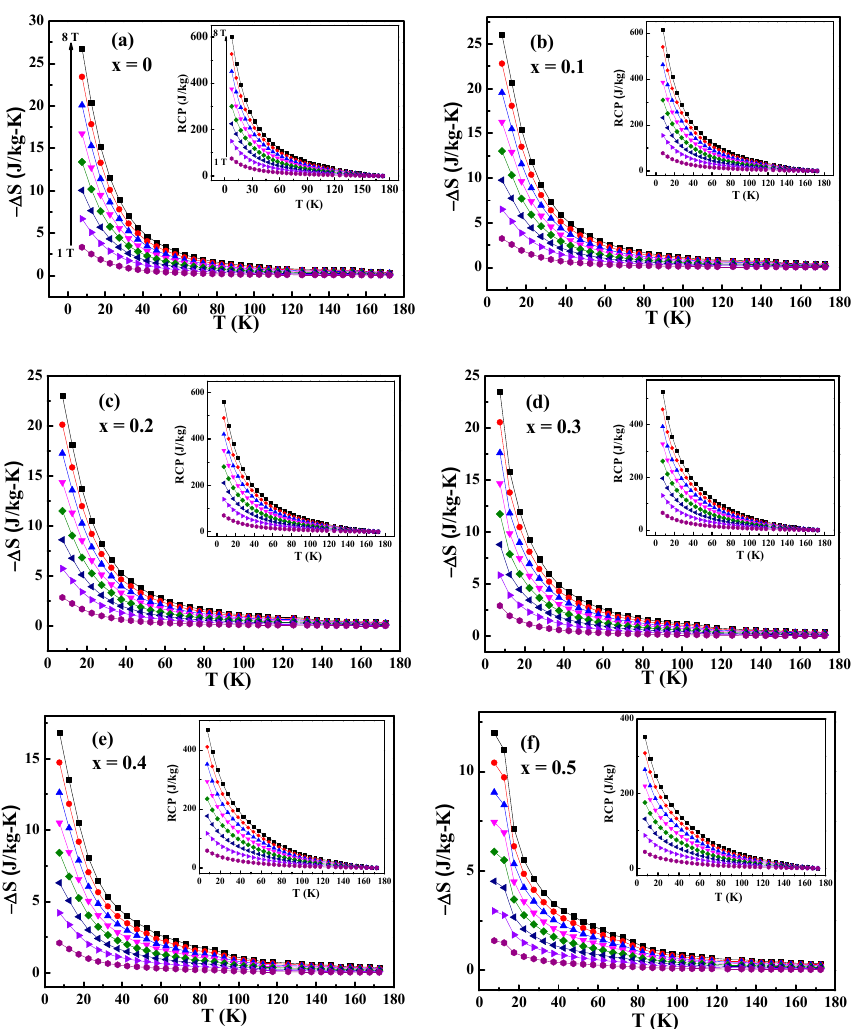
Figure 9. ( a – f ): The temperature dependence of magnetic entropy change ( − ∆ S ) and relative cooling power (inset) of GECMO series in magnetic fields up to 8 T.